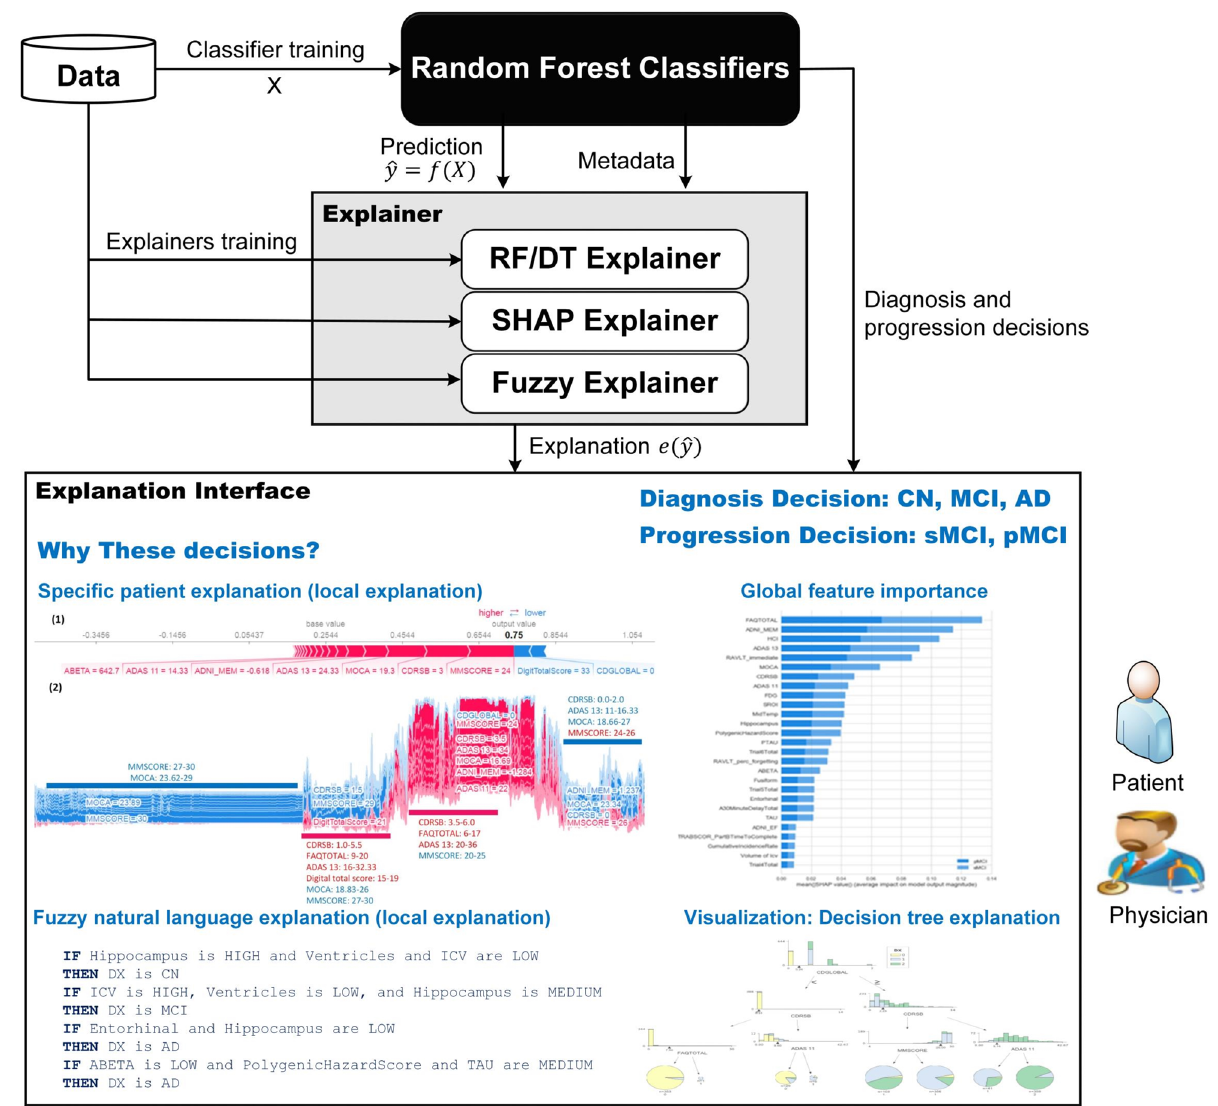
Figure 8. Roles of explainers to enhance RF